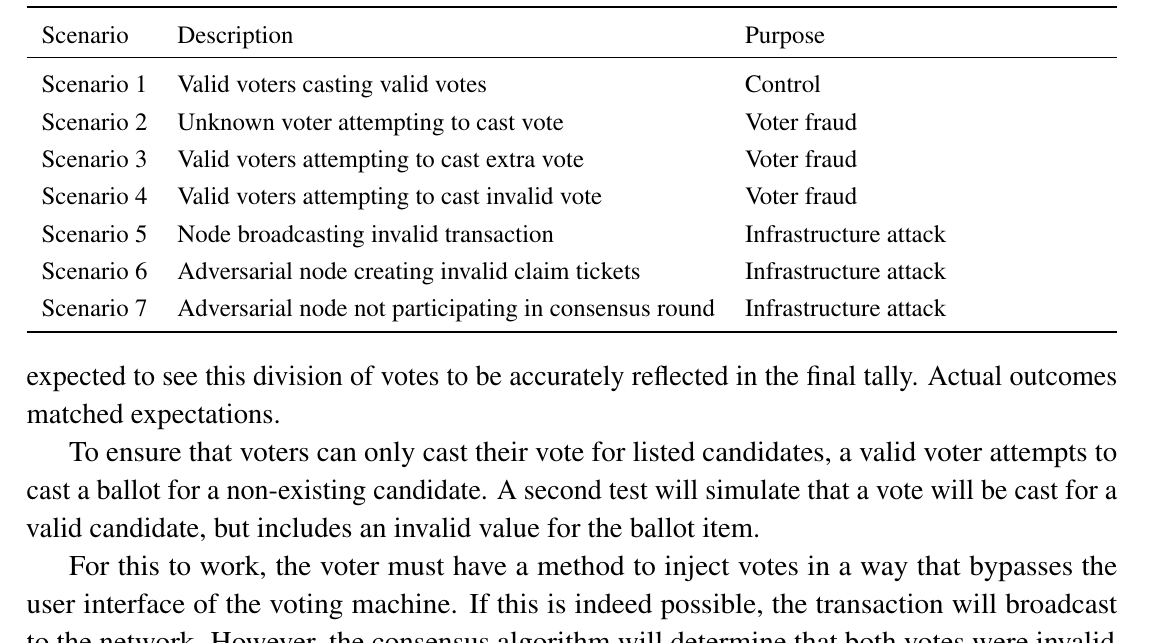
Table 3. Proof-of-Concept Testing